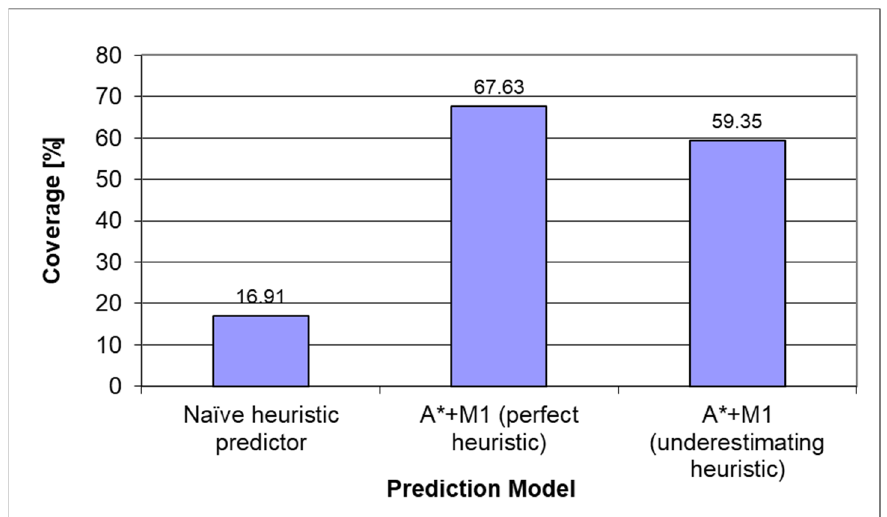
Figure 8. Heuristic comparison on the mixed dataset.